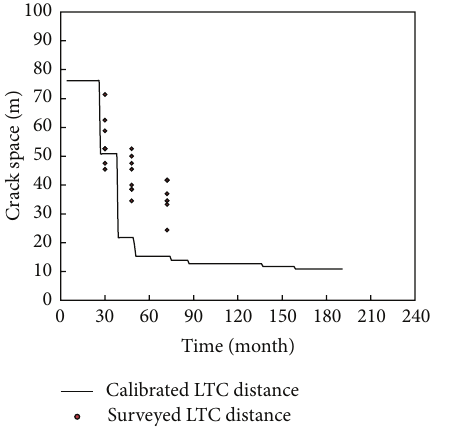
Figure 13: Calibrated thermal cracking versus surveyed thermal cracking on Haxihuan